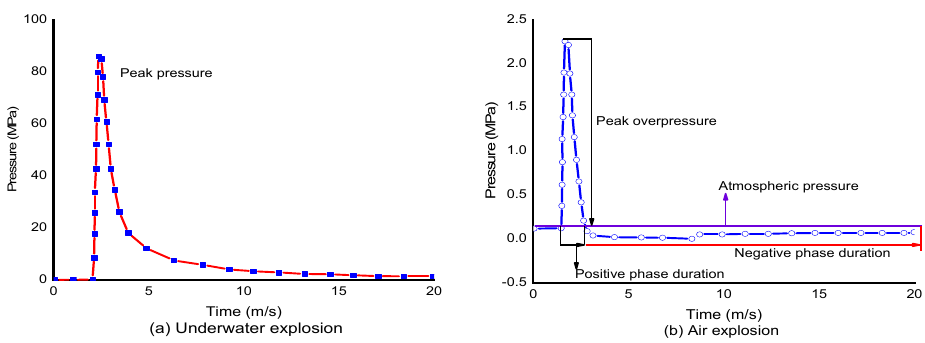
Figure 6. Typical pressure–time history curve at 5 m from the detonation’s